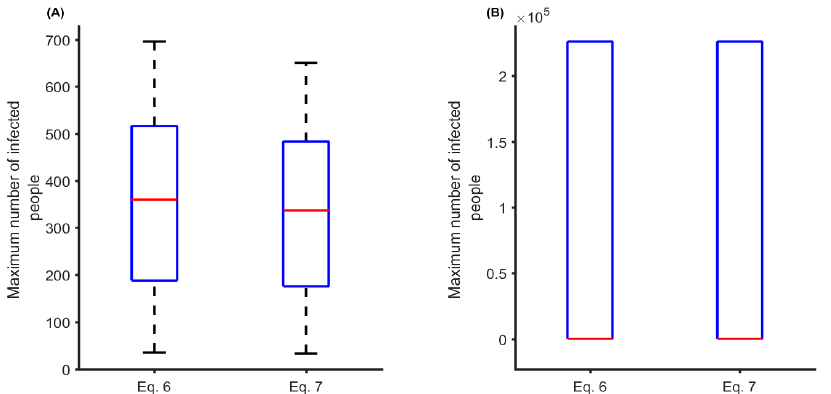
Figure 4. ( A ) The effects of the initial number of infected people on the peak of the epidemic curve. In ( A ), we assume I 0 is uniformly distributed with integer random numbers between 10 and 200 inclusively. ( B ) The variability in the peak of infection due to varying biting rate ( α ∈ U ( 0.01, 3.75 )) and transmission probability ( β ∈ U ( 0.01, 0.75 )) . In this case, the initial number of infected people is 30 based on the year-to-date (YTD) number of notifiable mosquito-borne diseases (MBDs) in Townsville as of 7 February 2019 [15].